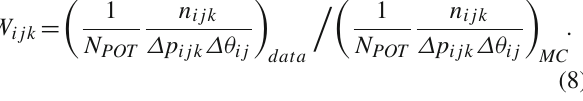
Fig. 46 Double differential yields of negatively charged kaons for the downstream target face ( z = 90 cm). Vertical bars represent the total uncertanties. Predictions from the NuBeam (solid blue line) and